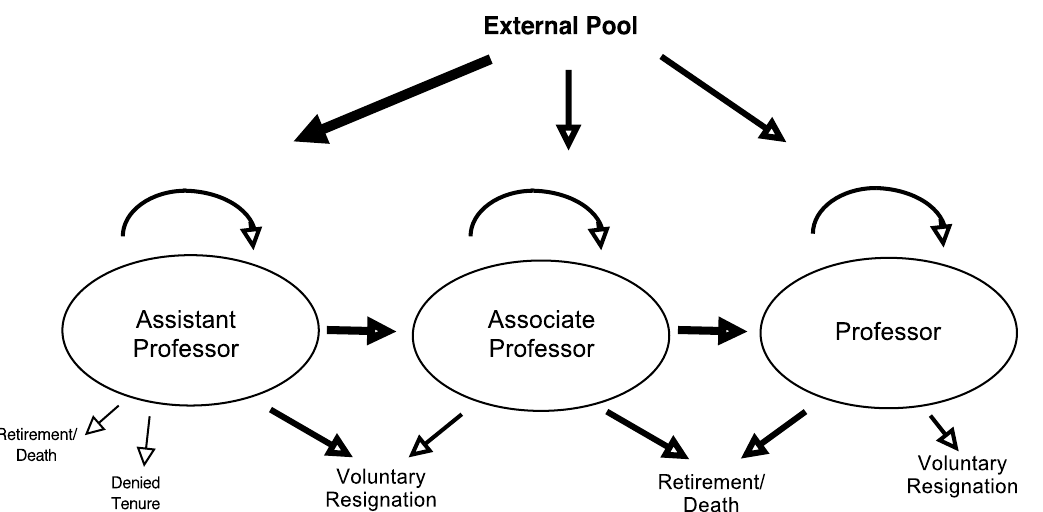
Fig 1. Model of faculty flux. Our analysis of faculty flux examined transitions between possible states. Arrow size denotes observed relative magnitude of different transitions across a seven-year interval.